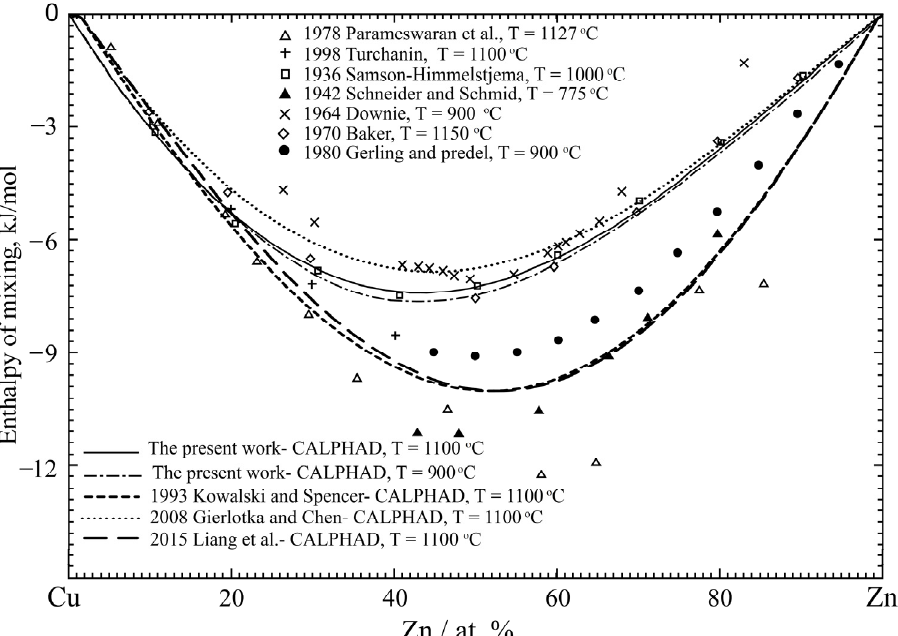
Figure 3. The calculated enthalpy of the mixing of the liquid phase at 900 and 1100 °C in the Cu-Zn system compared with the experimental data from refs. [58–61,63,68,70] and previously optimized calculations data from refs. [45,48,50].